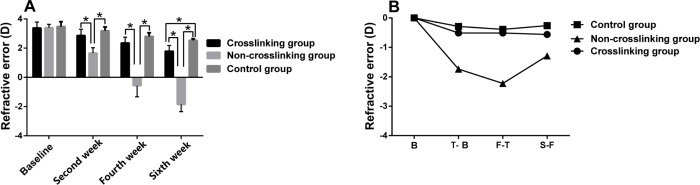
The comparison of refractive error (diopter) (A) between the three groups. Top of the box plot represents the mean and the bar of each box represents the standard deviation. The trend graph of refractive error (B). Triangle, square and circle represent the means. *Statistical significance (p < 0.05) between the groups. B: the value of refractive error (baseline) T-B: the value of diopter change (second week minus baseline); F-T: the value of diopter change (fourth week minus second week); S-F: the value of diopter change (sixth week minus fourth week).